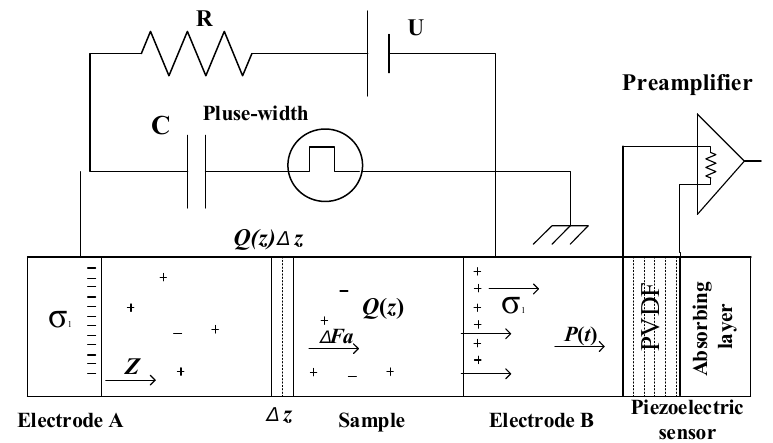
Figure 2. The schematic diagram of the PEA test.